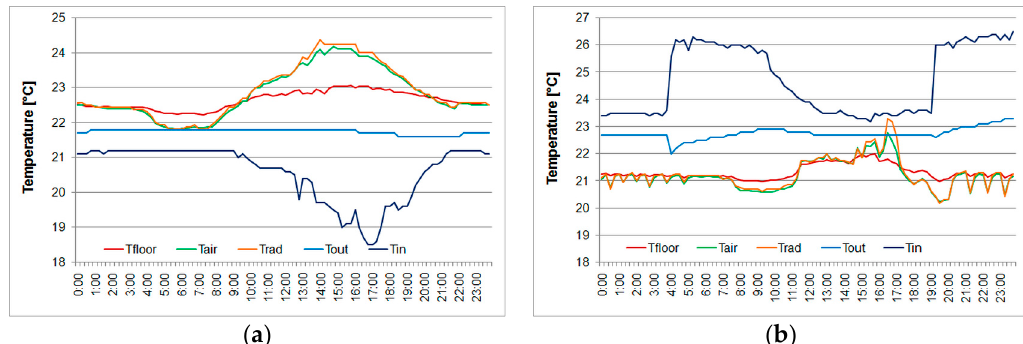
Figure 23. Measured floor (Tfloor), air (Tair), radiative (Trad), outlet water (Tout) and inlet water (Tin) temperatures on working days: ( a ) 8 August 2019; ( b ) 30 October 2019.